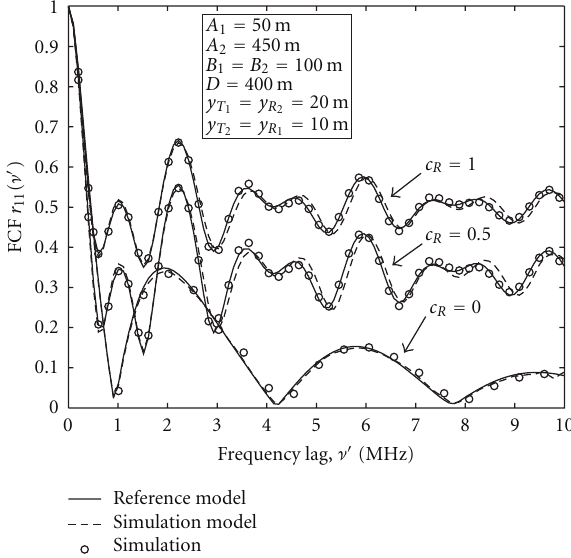
Figure 8: Absolute values of the FCFs | r 11 ( ν (cid:4) ) | (reference model) and | (cid:29) r 11 ( ν (cid:4) ) | (simulation model) for di ff erent values of the Rice factor c R ∈ { 0,0 . 5,1 }